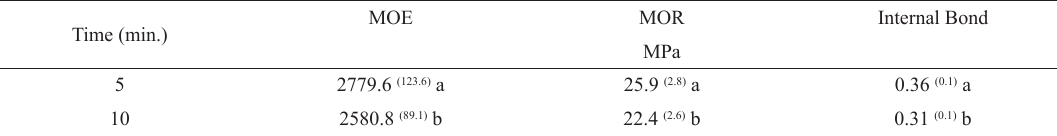
Table 9: Average values for MOE, MOR and Internal Bond in function of the time of the heat treatment applied to the MDF. Time